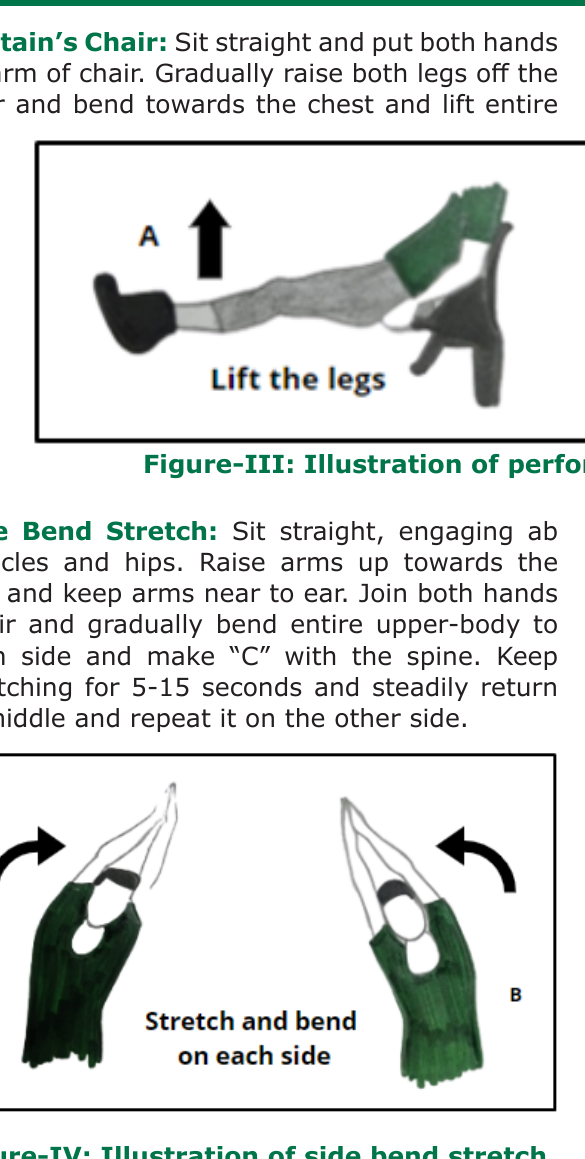
Figure-IV: Illustration of side bend stretch exercise.